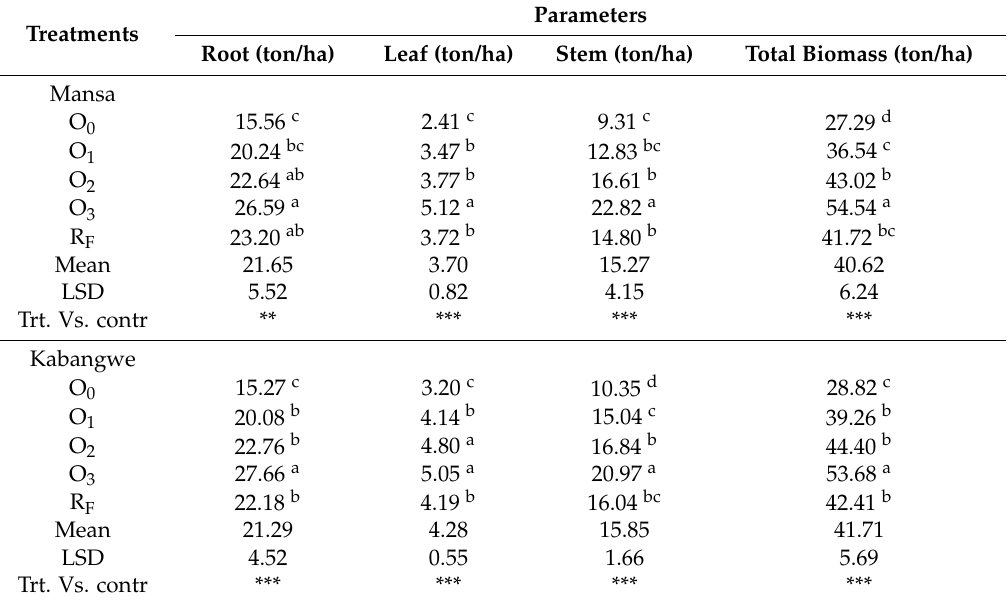
Table 5. Means of the effect of treatments on fresh cassava yield and